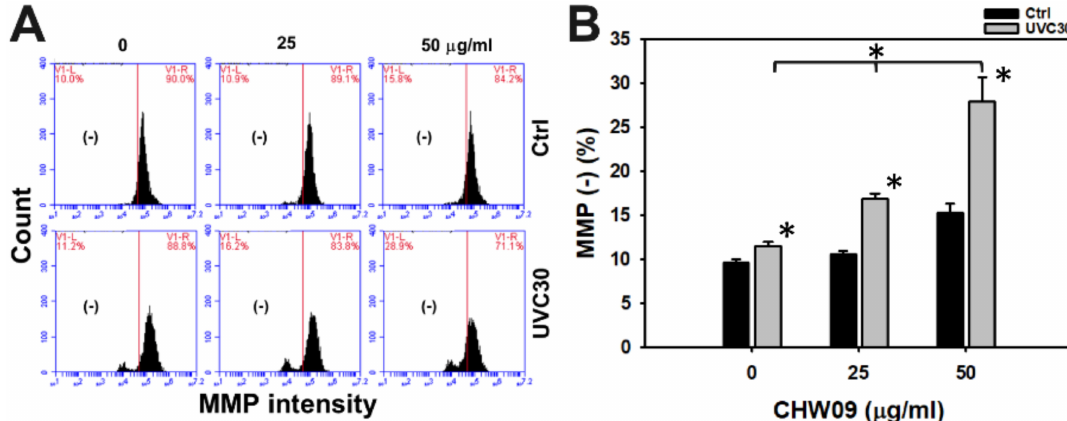
Figure 6. Changes of Mitochondrial Membrane Potential (MMP) of UVC and / or CHW09 treatments in oral cancer Ca9-22 cells. Cells were pretreated with UVC irradiation (0 and 30 J / m 2 ) and / or post-treated with CHW09 (control, 25, and 50 µ g / mL) for 24 h. ( A ) Representative pattern of MMP analysis for UVC and / or CHW09 treatment. (-) in the left side of each panel indicates the MMP negative percentage ( − ) (%). ( B ) Statistics in Figure 6A. Data, mean ± SD ( n = 3 independent experiments). For multiple comparison, significance of the di ff erence was examined by one-way ANOVA and the Tukey HSD Post Hoc Test. *, p < 0.0001. * without line indicates the significance between control and UVC30. * with line indicates the significance between UVC30 / CHW09 and